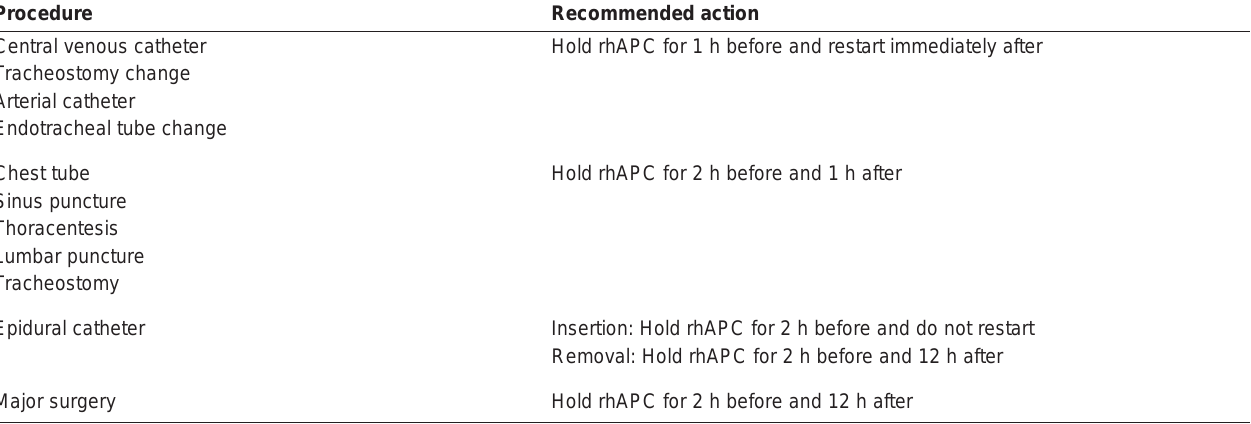
Invasive procedures during the recombinant human activated protein C (rhAPC) infusion, as per the PROWESS